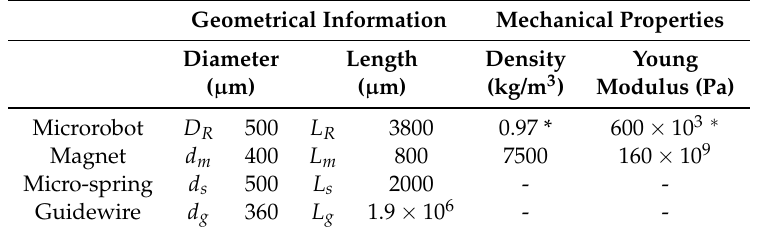
Table 1. Geometrical information and mechanical properties of the